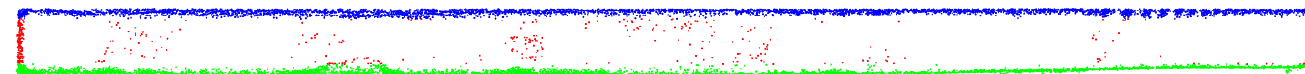
Figure 18. Segmented points representing belt longitudinal edges (in blue and green) and noise (in red).